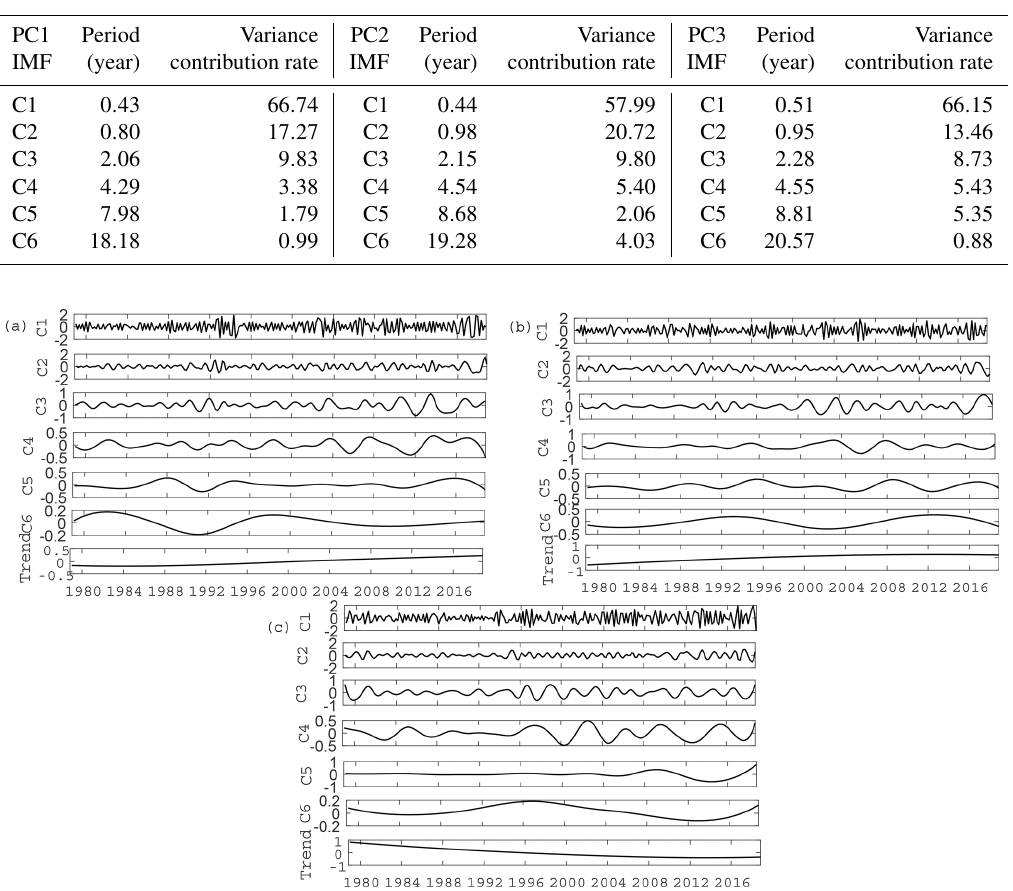
Figure 7. The IMF modes and trend components after EEMD of the first EOF temporal coefficient (a) , the second EOF temporal coeffi- cient (b) and the third EOF temporal coefficient (c)